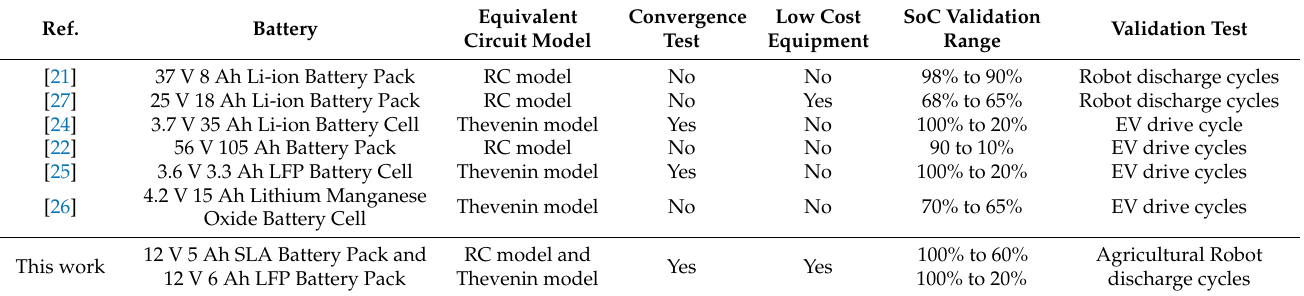
Table 1. Comparison of presented work with previous